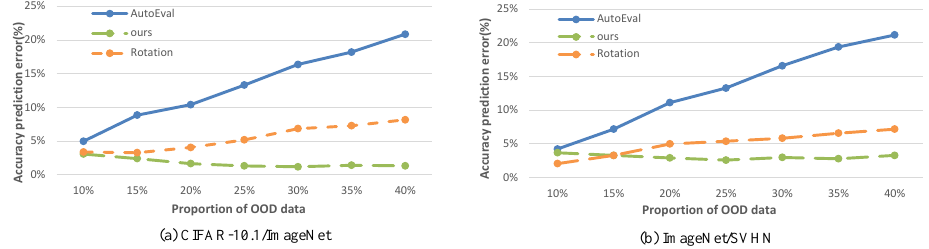
Figure 4. The error changes of our method under different proportions of OOD data. When the proportion of OOD data is low, our method only shows a slight improvement over other methods. However, as the proportion of OOD data increases, our method’s superiority over other methods becomes more prominent. The dataset consists of ID data and OOD data from CIFAR-10.1/ImageNet ( a ) and ImageNet/SVHN ( b